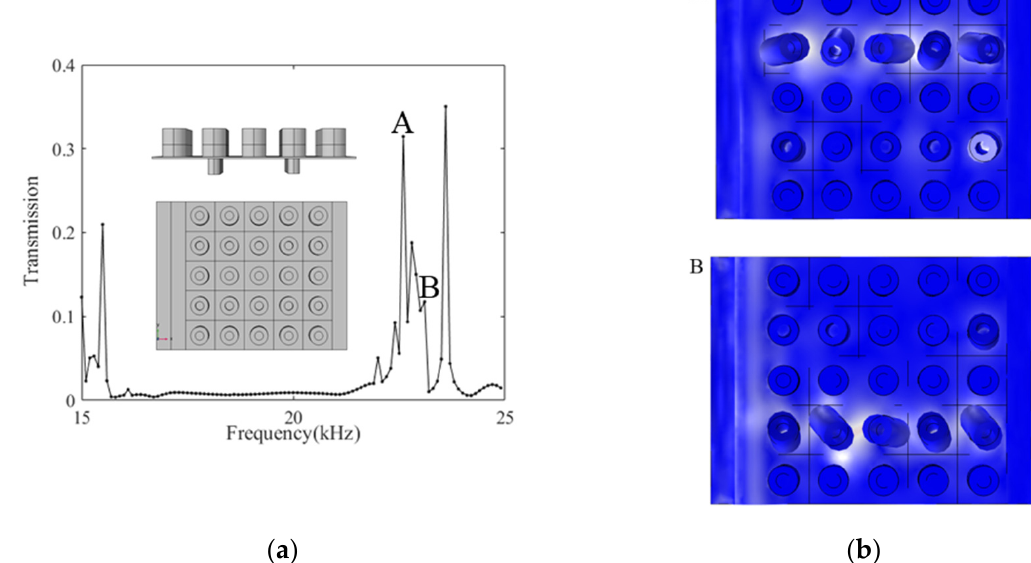
Figure 11. Schematic representation of a multichannel wavelength multiplexer. ( a ) The transmission spectrum of anti- symmetric Lamb waves when the FR in the waveguide FR (A) = 46.67% and FR (B) = 50%. ( b ) Displacement field distribution at two narrow-band frequencies A and B.